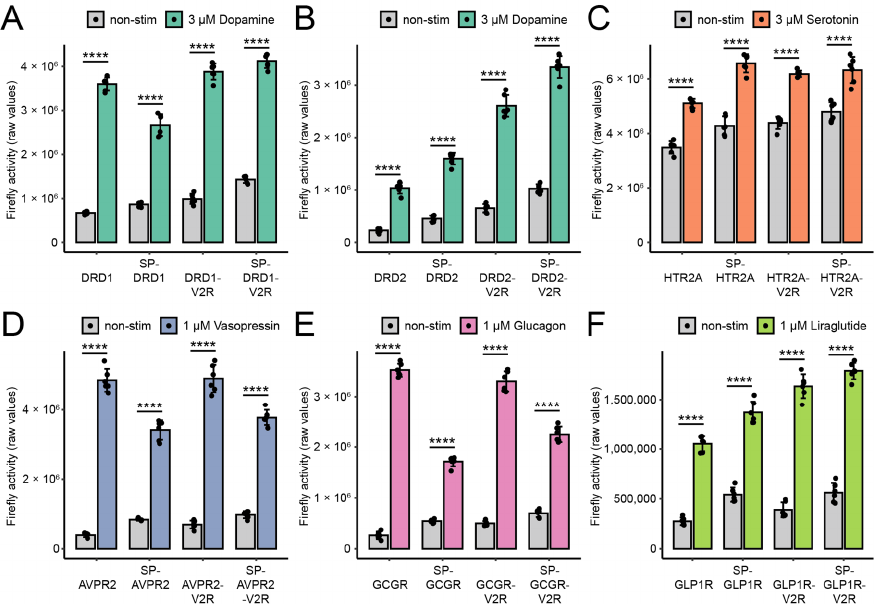
Figure 2. Split TEV GPCR β -arrestin-2 recruitment assays in HEK-293 cells. ( A – F ) Luciferase end- point assays for DRD1 ( A ), DRD2 ( B ), HTR2A ( C ), AVPR2 ( D ), GCGR ( E ), and GLP1R ( F ). All assays were conducted in HEK-293 cells in a 96-well format. Cells were stimulated for 6 h with their agonists. Note that the addition of the signal peptide and the V2R tail affected the performance of the split TEV GPCR β -arrestin-2 recruitment assays. Bar graphs display the means; the error bars represent the s.d. with six replicates per conditions. A two-tailed Student’s t test was used to determine the p -values for treatment versus control. **** p ≤ 0.0001.